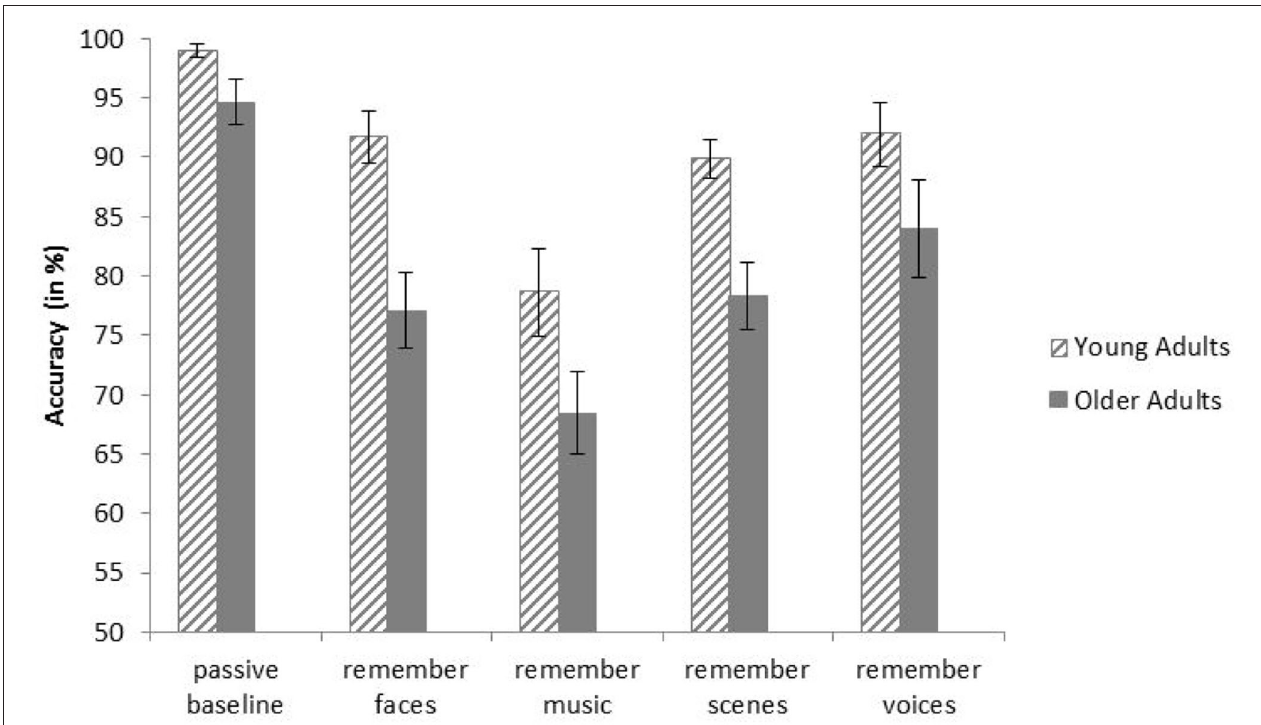
FIGURE 2 | Mean accuracies of younger and older adults in all conditions of the behavioral task. Error bars indicate one standard error of the